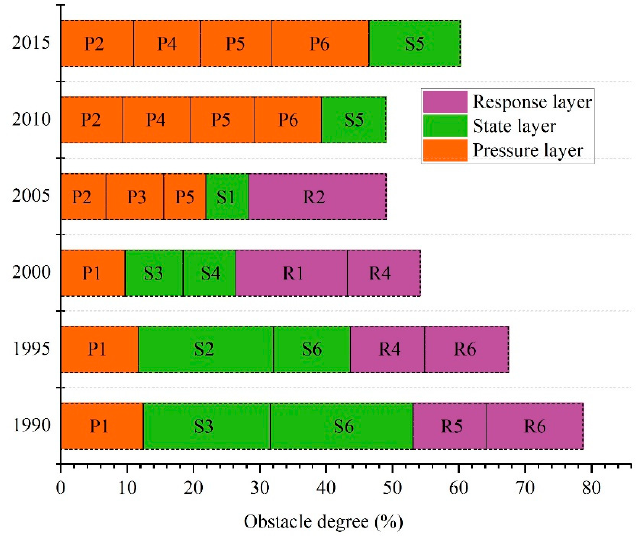
Figure 4. The obstacle degree of the top five key barriers to ecological security in the Pearl River Delta from 1990 to